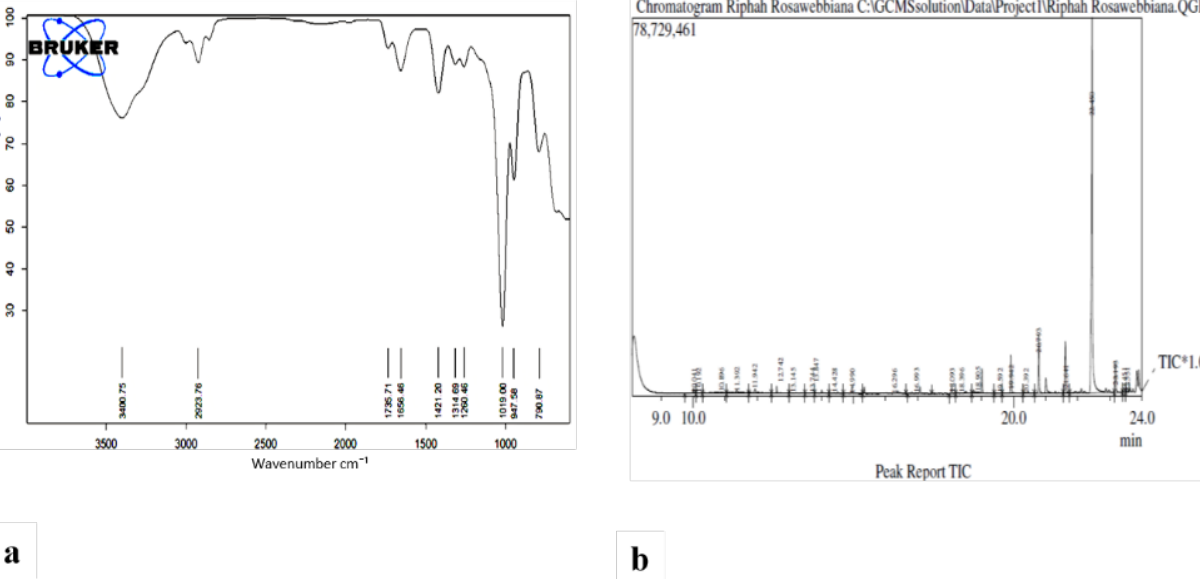
Figure 5. ( a ) FTIR spectra of n -hexane extract of Rosa webbiana . ( b ) GC-MS chromatogram of the n -hexane extract of fruit of Figure 5. ( a ) FTIR spectra of n-hexane extract of Rosa webbiana . ( b ) GC-MS chromatogram of the n-hexane extract of fruit Figure 5. ( a ) FTIR spectra of n-hexane extract of Rosa webbiana . ( b ) GC-MS chromatogram of the n-hexane extract of fruit Figure 5. ( a ) FTIR spectra of n-hexane extract of Rosa webbiana . ( b ) GC-MS chromatogram of the n-hexane extract of fruit Rosa webbiana of Rosa webbiana . of Rosa webbiana . of Rosa webbiana .